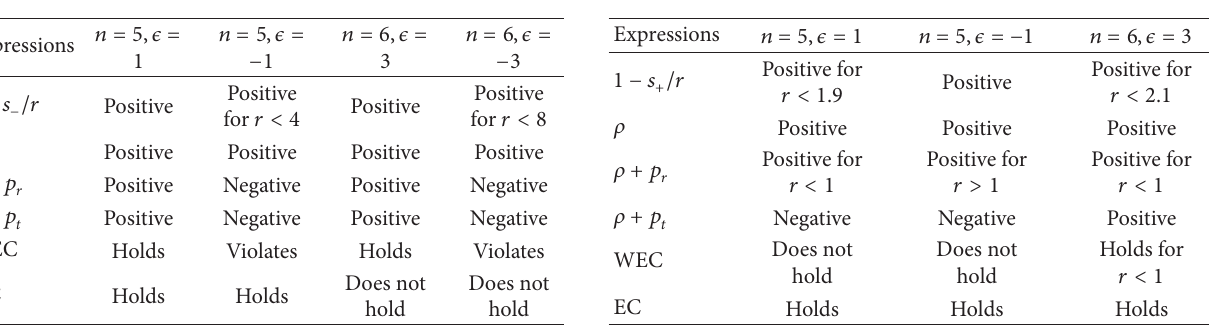
Table 3: Wormhole solutions with Lorentzian noncommutative background for 𝑠 +